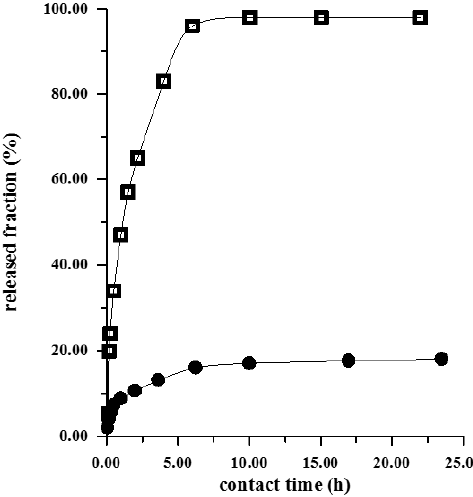
Figure 9. Relative fraction of extracted antioxidant (AO) as a function of contact time (h) with ethanol for samples: (•) EOC- g -(BHB-T)_2; ( □ ) EOC/CY_2.